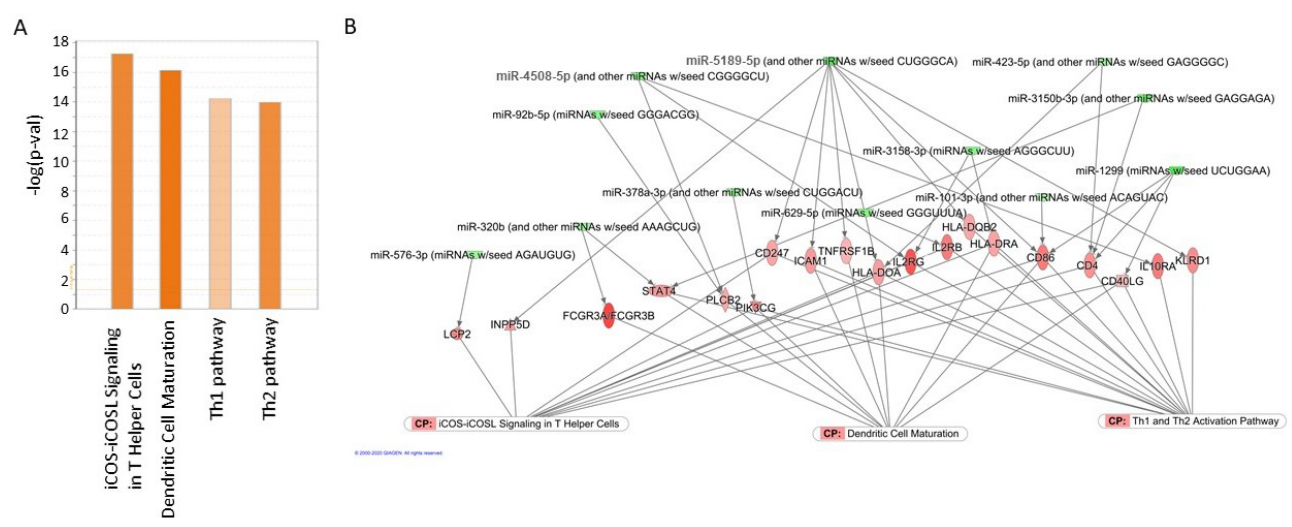
Figure 6. Pathway integration of miRNAs and mRNA changes using IPA. ( A ) Canonical pathways enriched in TG based on gene expression changes using IPA. ( B ) Changes in miRNAs can explain the changes in canonical pathways. Green: Repression Red: